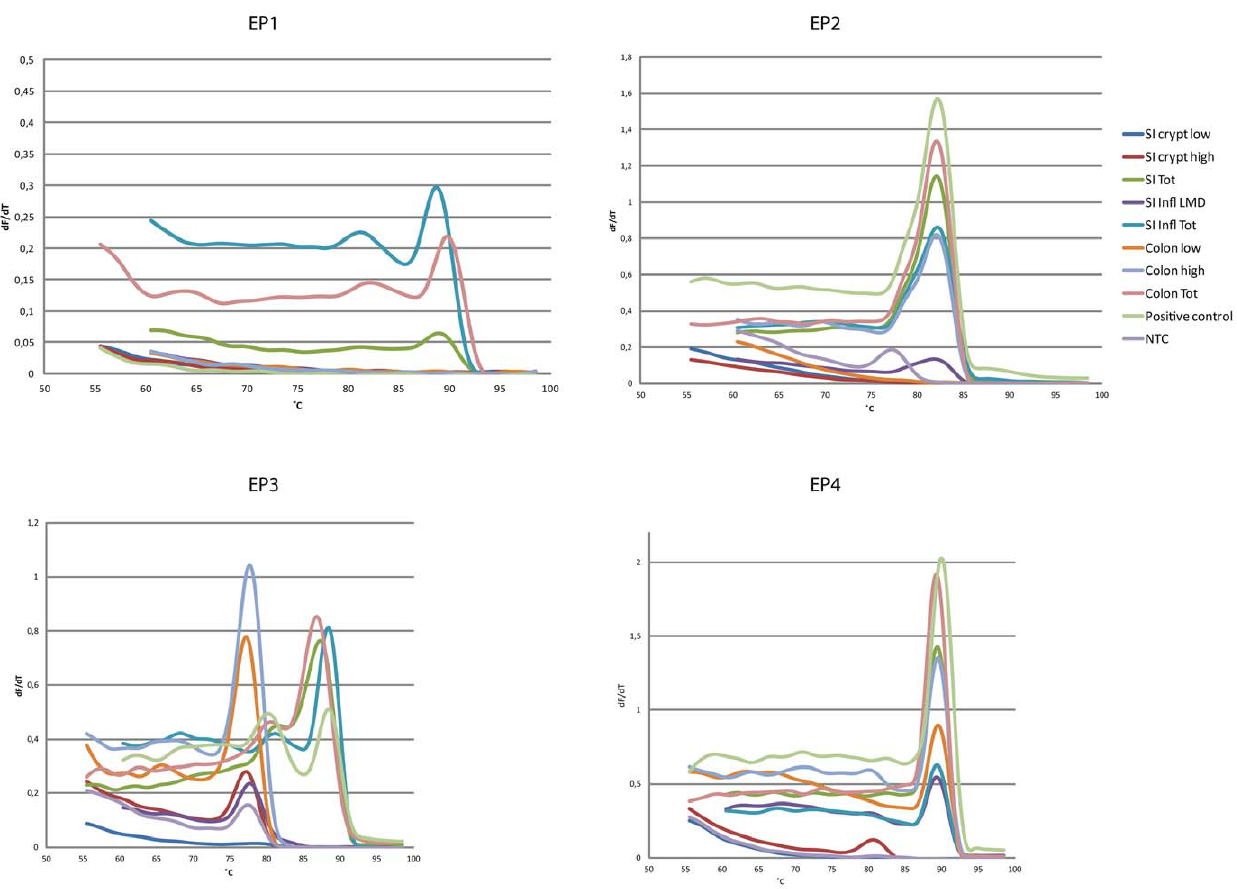
Figure 3. EP-receptor gene expression in normal and inflamed human intestine. Cells from the different populations described above were dissected by LMD from normal human small intestine and colon, and inflamed small intestinal tissue. RNA were isolated from the dissected cells and analyzed by RT-PCR for the expression of EP-receptors 1-4. Amplification of the EP receptor PCR products were verified by correct melting temperature.